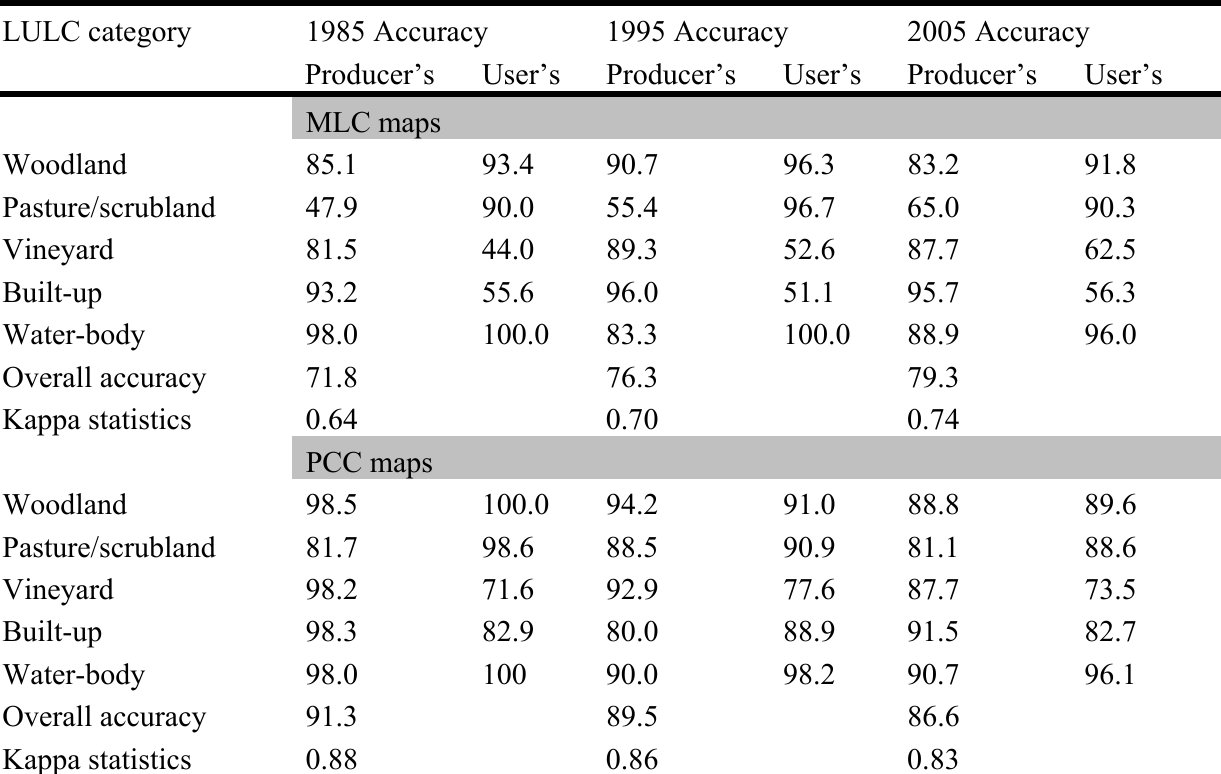
Table 3. Summary of Accuracy (%) and Kappa statistics of MLC and PCC